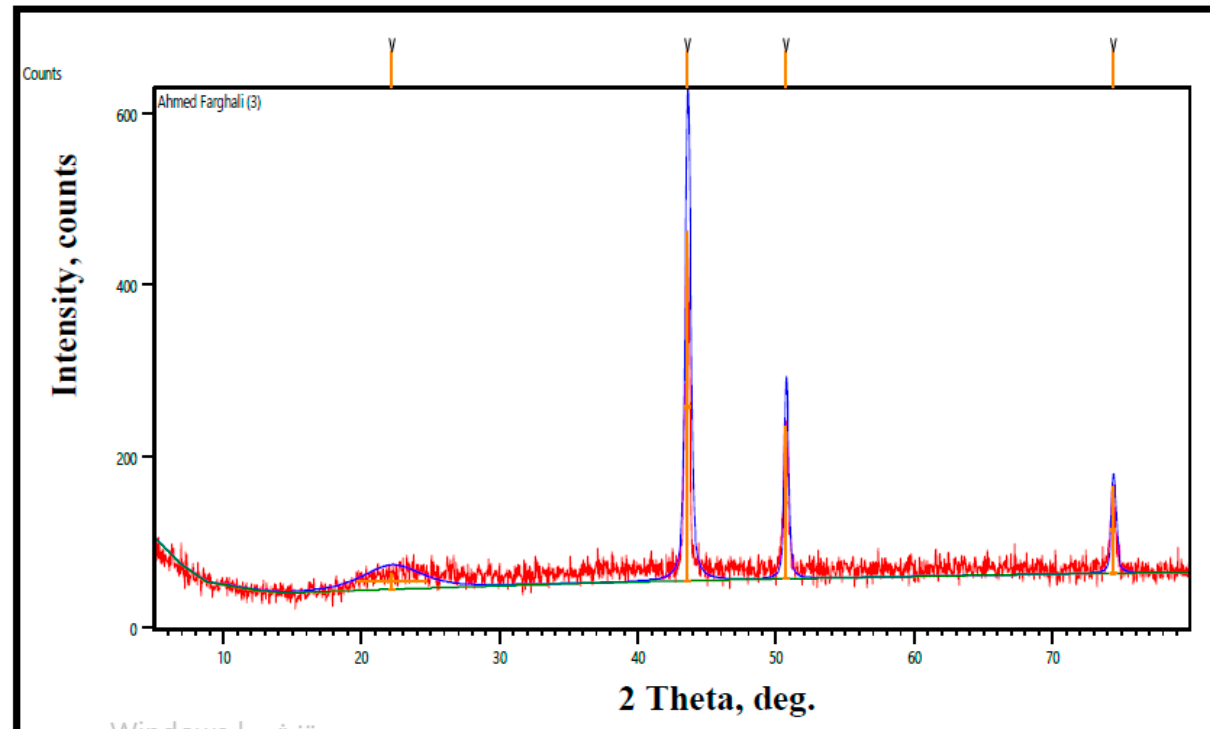
Figure 6. XRD patterns of pure CuO and rGO/CuO composites at room temperature.